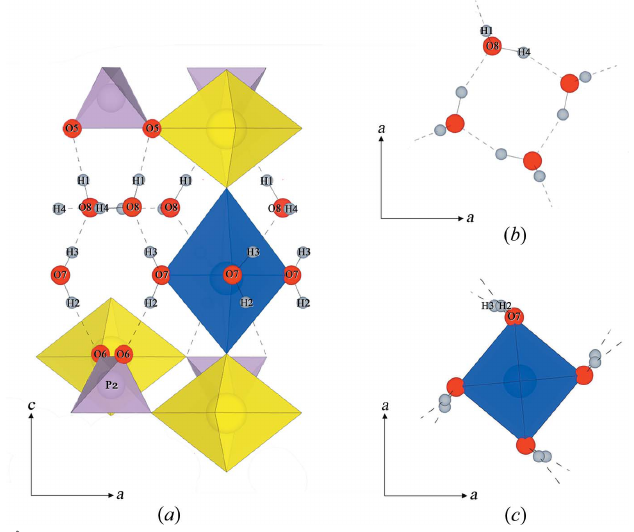
Figure 7 ( a ) An ac projection of part of the metatorbernite model, highlighting the configuration of interlayer water molecules and the hydrogen-bond network. Atoms involved in hydrogen bonding are labelled. ( b ) The square planar configuration of free water molecules. ( c ) The square planar configuration of copper-coordinating water molecules.